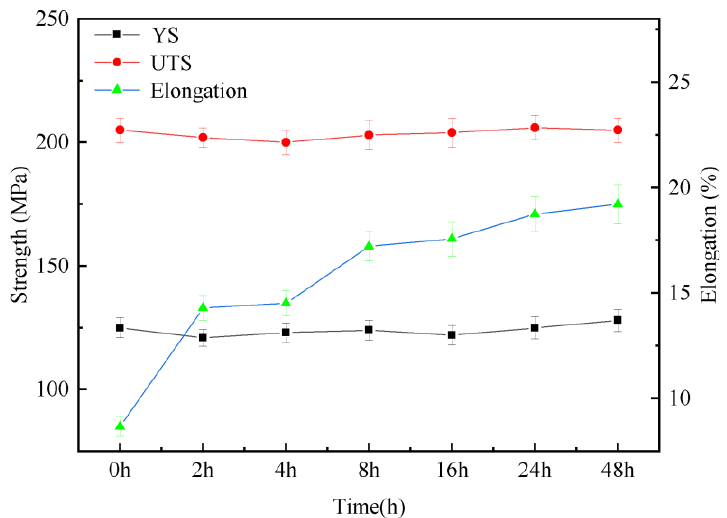
Figure 9. HAADF-STEM morphology and EDS mapping of Al 2 RE phase at the grain boundary of the Mg-3Y-4Nd-2Al alloy after solution treatment for 2 h: ( a ) HAADF-STEM morphology, ( b ) EDS mapping.